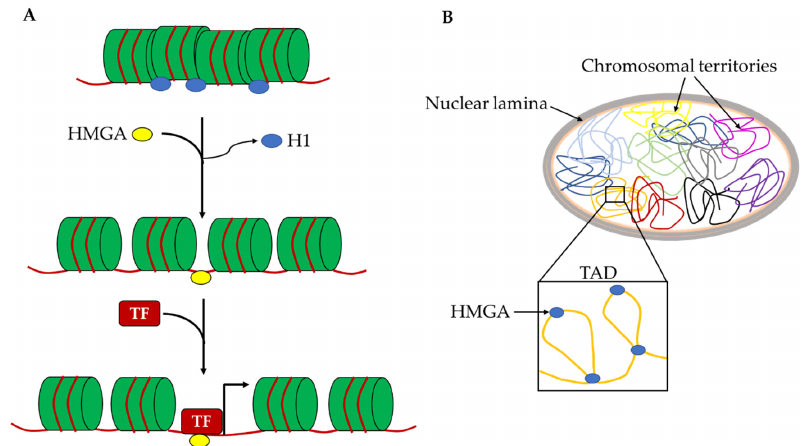
Figure 3. Schematic representation of hypothetical roles of HMGA proteins in the chromatin architecture. ( A ) Hmga proteins can allow the accessibility to pioneer TFs on naïve chromatin by displacing H1 histone. ( B ) Hmga2 proteins can contribute to the organization of chromosomal territories and their subdomains (TADs) by generating specific DNA loops. H1: histone H1; TF: transcription factor; TAD: topological associated domain.